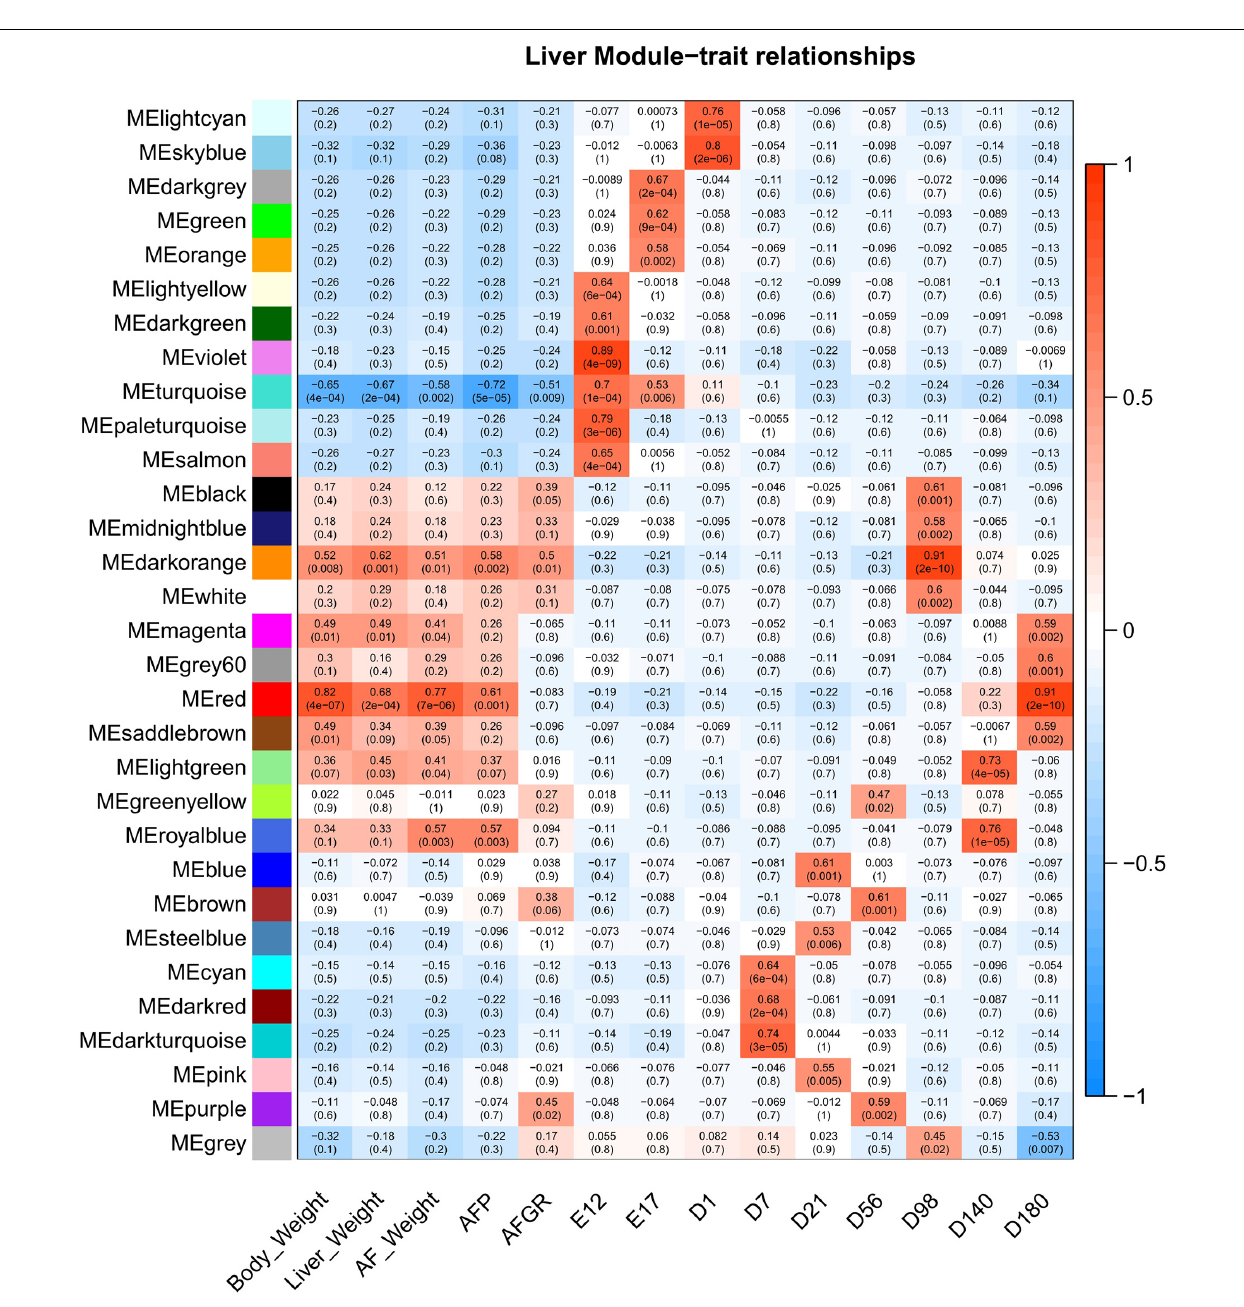
FIGURE 5 | The liver expressed genes WGCNA module–trait relationship. WGCNA, weighted gene co-expression network